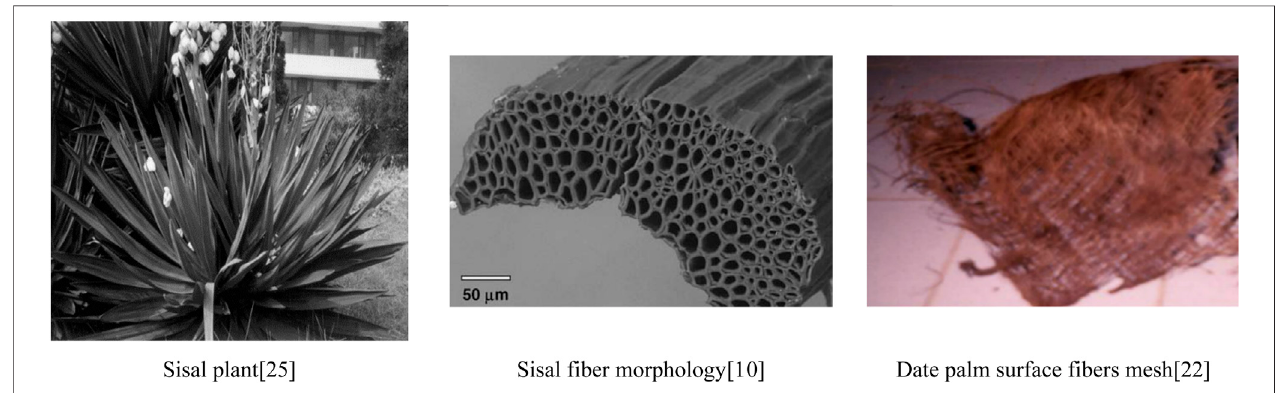
FIGURE 3 | Substitution and mixing amount of natural plant fi ber in concrete in other literatures.